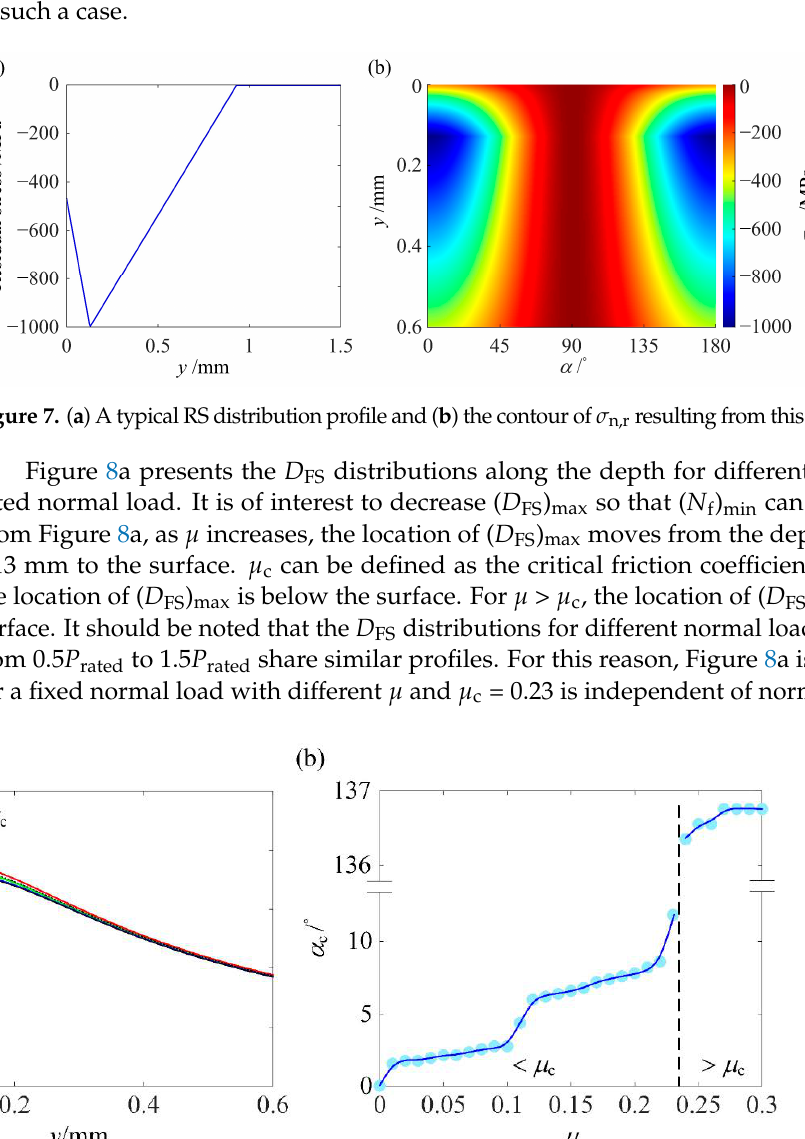
Figure 6. The contour of Δ γ / Δ γ max , σ n,max /| σ n,max | max and the Fatemi–Socie damage parameter (FSDP)/(FSDP) max for P / P rated = 1 and μ = 0, 0.1, and 0.3.